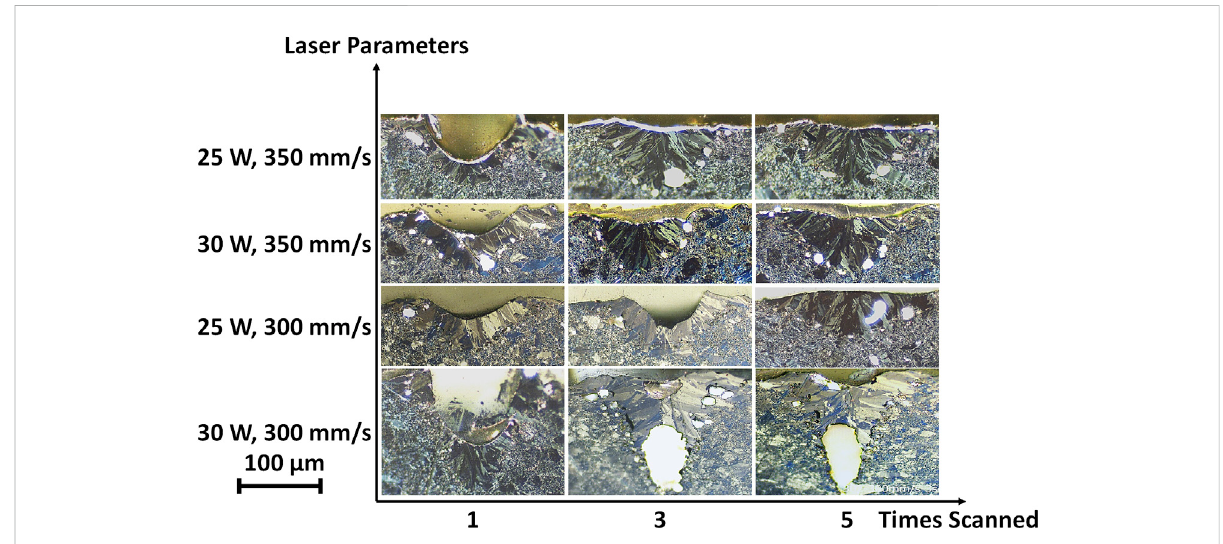
FIGURE 6 Polarized light microscopy images of the melt pool cross sections showing columnar dendritic